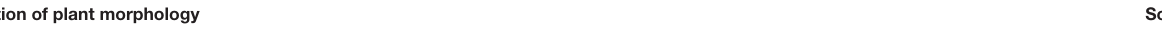
TABLE 2 | Evaluation of oat phenotypic traits under water stress. Description of plant